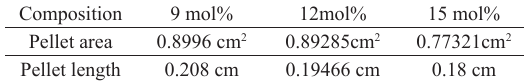
Table 3. Pellet area and length of